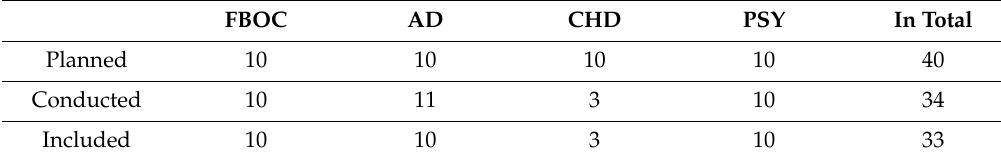
Table 1. Interviews conducted and included in the data